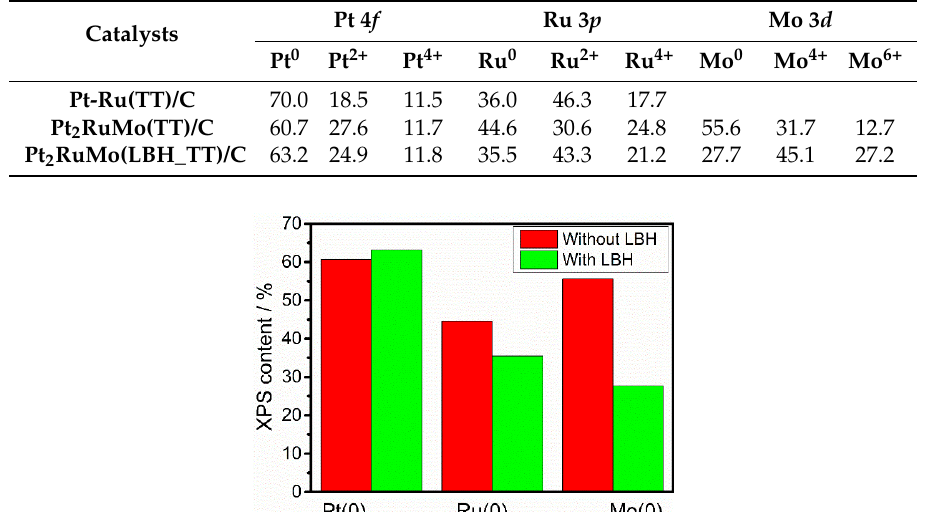
Table 2. Relative amount of different oxidation states (at %) in PtRu/C and Pt 2 RuMo/C catalysts from XPS measurements.